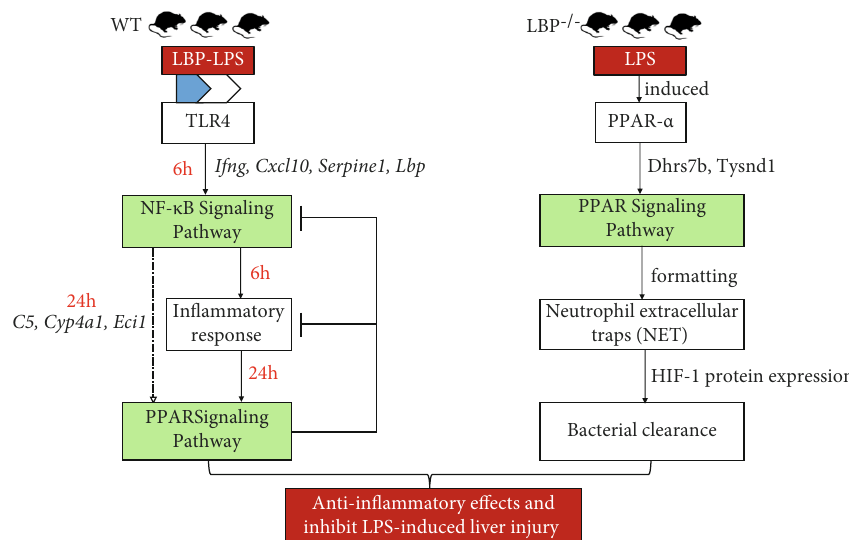
Figure 4: A proposed model of the WT and LBP-de fi cient rats after LPS administration. The upregulation of Ifng , Cxcl10 , Serpine1 , and Lbp in WT rats triggers NF- κ B signaling pathway-induced in fl ammation response at 6 h after LPS injection, while the PPAR signaling pathway plays a part in bacterial clearance via the formation of NET by highlighted genes of C5 , Cyp4a1 , and Eci1 at 24h after LPS administration in SD rats and of Dhrs7b and Tysnd1 in the LBP -/-